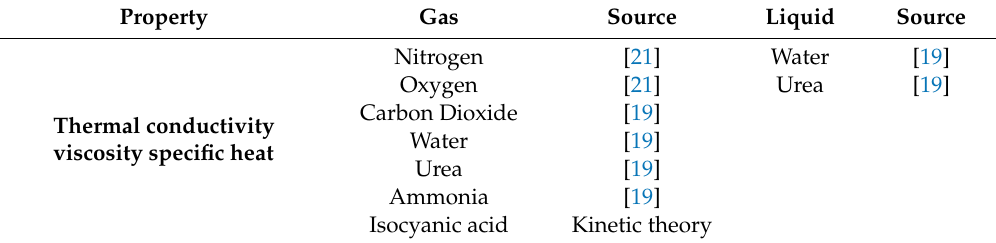
Table 4. Sources physical of gaseous and liquid materials used in the